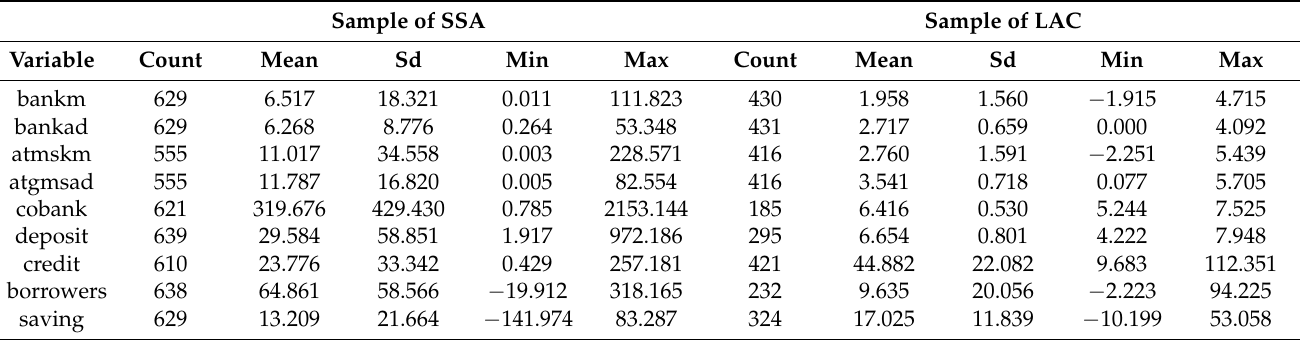
Table 3. Descriptive statistics of financial inclusion indicators.